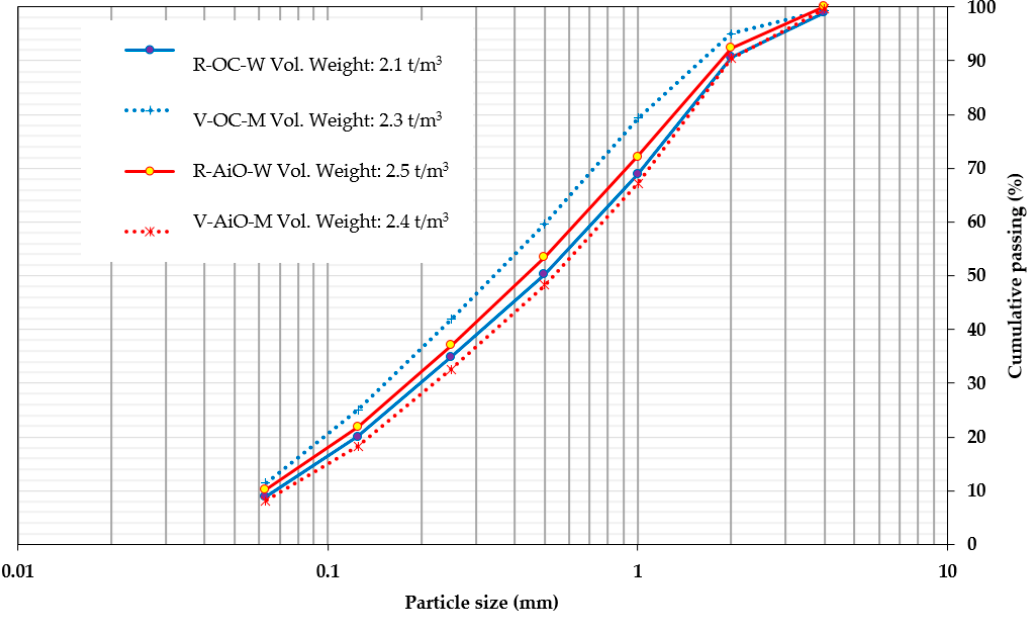
Figure 5. Profiles and volumetric weights of the crushed samples.